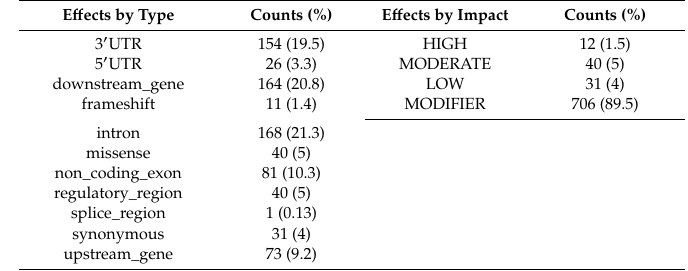
Table 1. Summary of e ff ect types and impact of single nucleotide polymorphisms (SNPs) identified by RNA-Seq analysis. SNPs included in this table are those associated with symptomatology with a p < 0.05. E ff ect type refers to the predicted e ff ect the change implies. These variants can have one of four grades of biological impact: low (e.g., synonymous amino acid change), moderate (e.g., non-synonymous amino acid change), modifier (term used for di ffi cult to predict e ff ects; e.g., variants in 3 (cid:48) UTR, 5 (cid:48) UTR, intron, regulatory region) and high (e.g., frameshift, abolishment of splice region) impact. E ff ects by Type